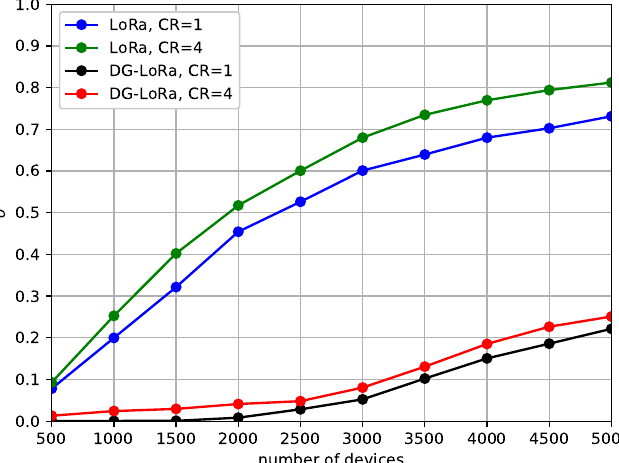
Figure 12. The number of retransmissions according to the coding